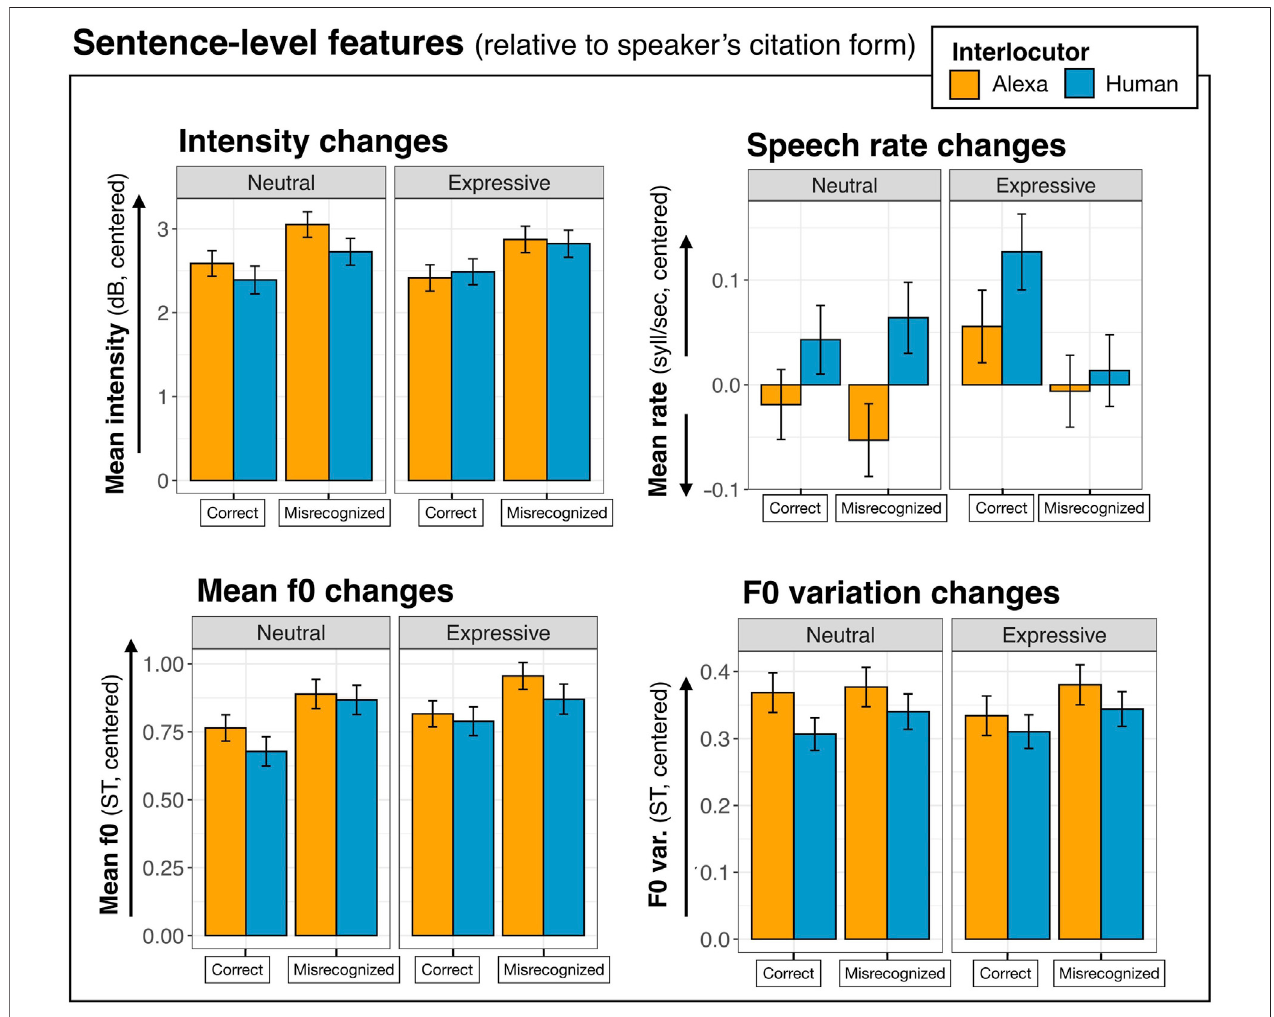
FIGURE 3 | Mean acoustic changes from speakers ’ citation form productions to the interaction with the Interlocutors (Alexa vs. human) for sentence intensity (in decibels,dB),speechrate(syllablespersecond),f0(semitones,ST,rel.to100 Hz),andf0variation(ST).The x -axisshowsStagedMisunderstandingCondition(correctly heard vs. misrecognized), while Expressiveness Condition is faceted. Values higher than 0.0 indicate an increase (relative to speakers ’ citation form), while values lower than 0.0 indicate a relative decrease. Error bars depict the standard error.